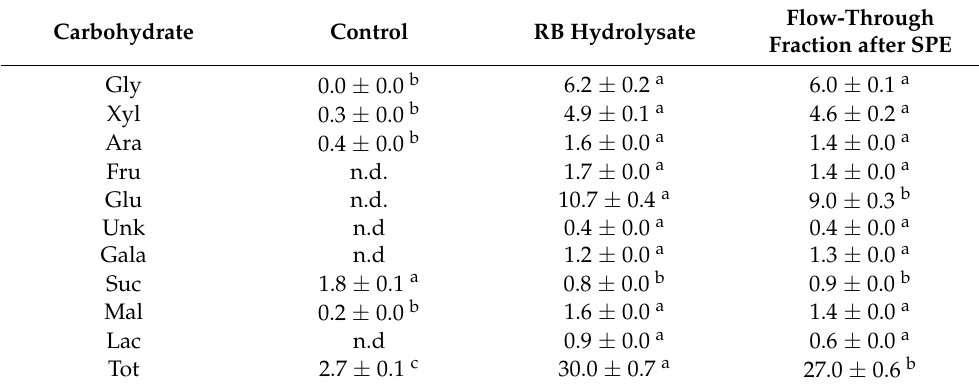
Table 4. The concentration of mono- and disaccharides after enzymatic hydrolysis of rye bran for 48 h using multi-enzyme complex Viscozyme L, mg mL − 1